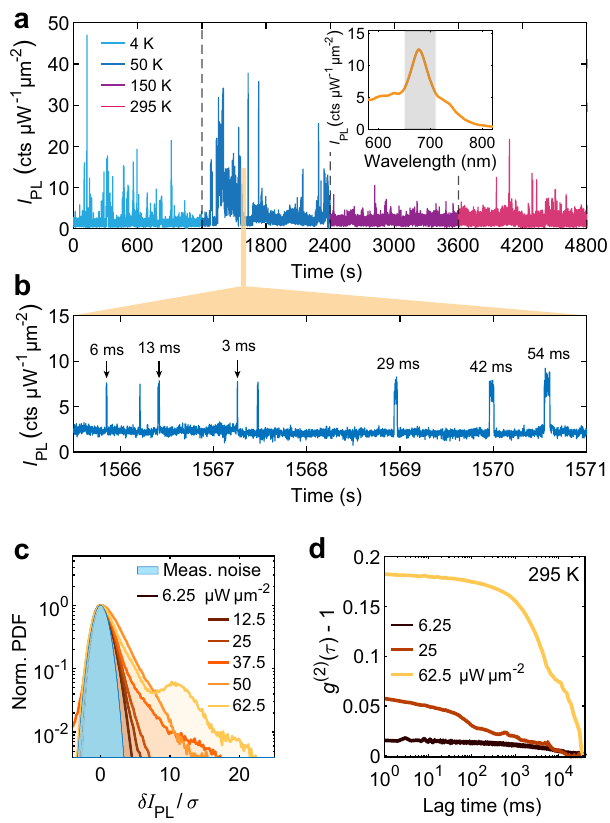
Fig. 5 PL blinking as a function of laser power and sample temperature. a Temperature-dependent time series of PL intensity from a nanojunction, with the time-averaged PL spectrum shown in the inset. The PL signal was measured by a single photon counting module after spectral fi ltering (range shown in inset). Binning time, 1 ms. Excitation power density: ~50 μ W μ m − 2 , b enlarged view of a revealing shorter blinking events. More data presented in Supplementary Fig. 16 suggest that no clear relationship exists between temperature and blinking statistics. c Probability density functions (PDFs) of peak PL intensity as a function of excitation intensity (room temperature) plotted against the re-scaled intensity δ I PL / σ to enable comparison. Here δ I PL represents the PL intensity deviation from the peak of the PDF; σ is the standard deviation of the measurement noise at this signal level. The PDFs are all centered around the averaged PL of the “ OFF ” state and normalized to the respective measurement noise (blue area). The corresponding time series can be found in Supplementary Fig. 17. d Autocorrelation function of the PL intensity trace at different excitation intensities, evidencing increased fl uctuations at higher laser computing the autocorrelation (Fig. 5d) of the PL intensity traces under different laser powers, evidencing a higher level of PL fl uctuation at higher laser powers. This result highlights the key role of local optical fi eld strength in activating the localized blinking emitters.